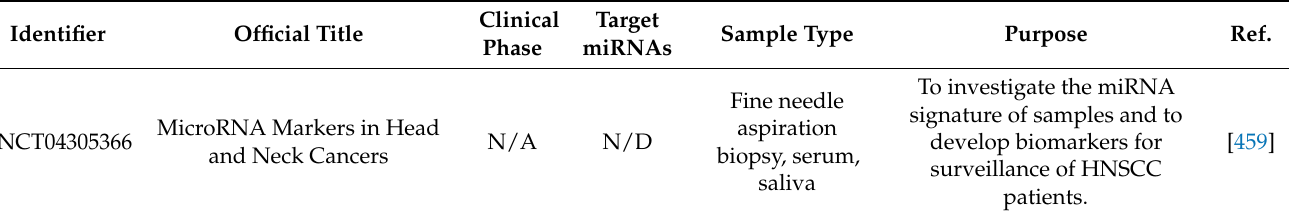
Table 6. Current clinical trials assessing miRNAs’ potential utility as